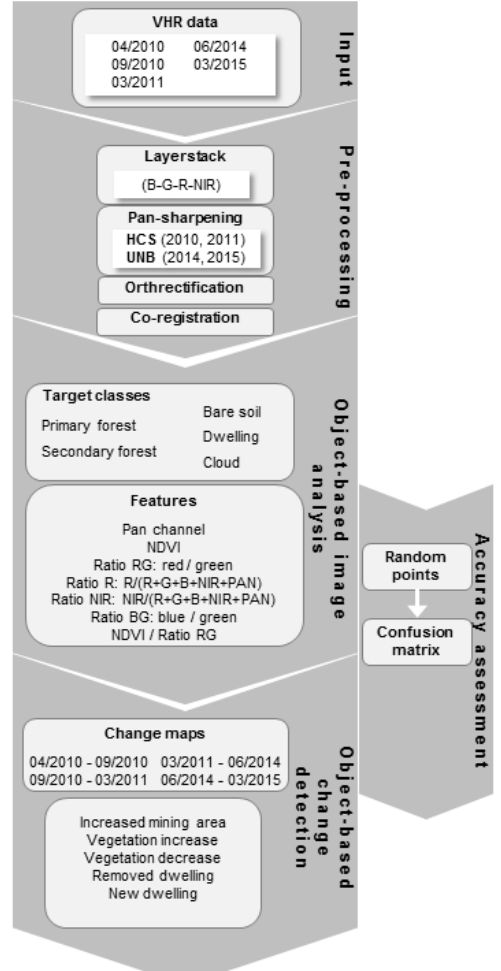
Fig. 2. Methodological